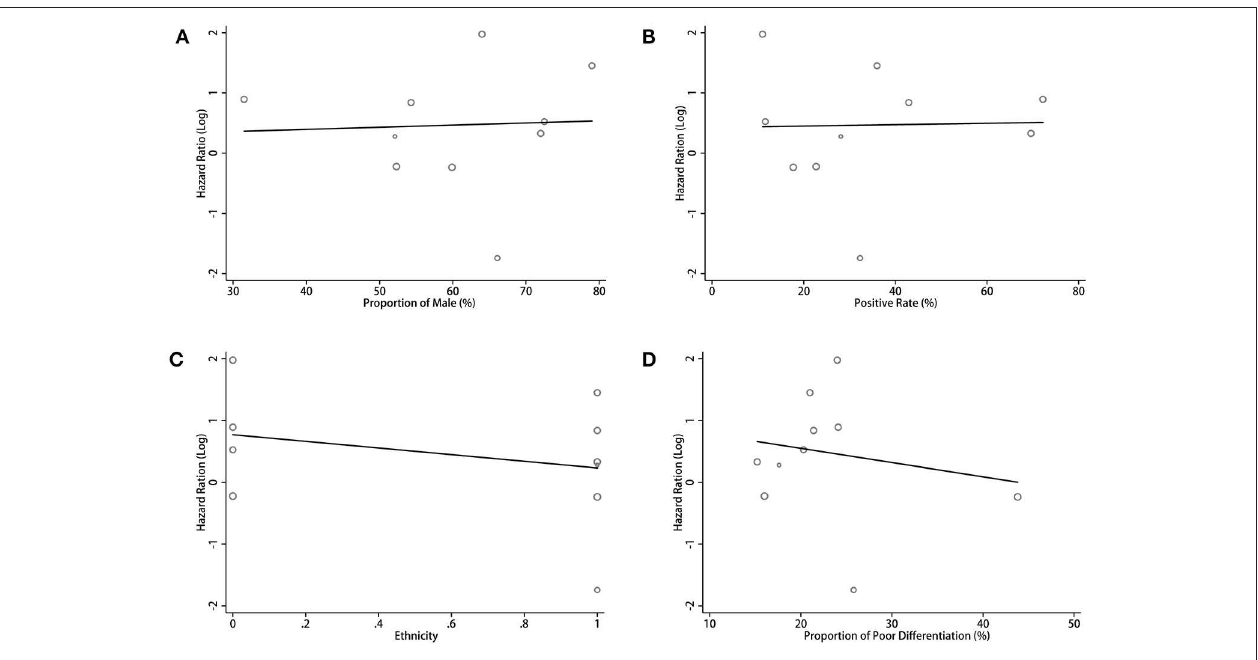
FIGURE 6 | Meta-regression analysis between PD-L1 expression in TCs and OS in CCA. Bubble plot with a fitted meta-regression line of the log hazard ratio: (A) proportion of Male (%); (B) positive rate (%); (C) ethnicity; (D) proportion of poor differentiation